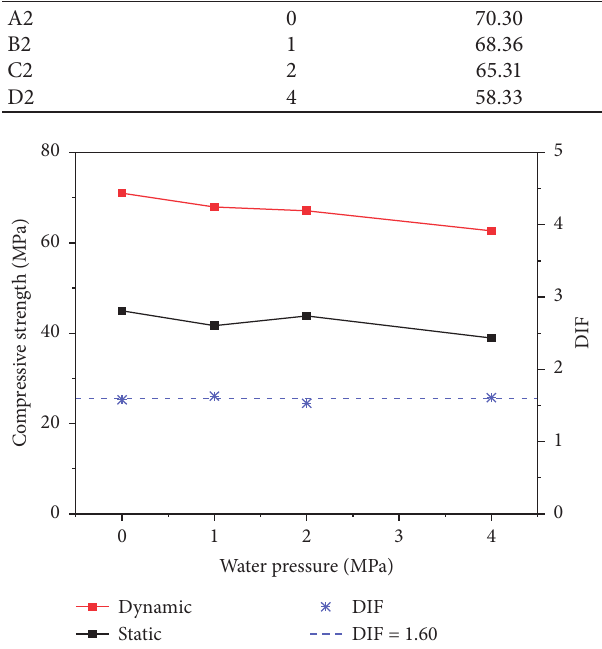
Figure 6: Influence of loading rate on compressive strength of concrete.